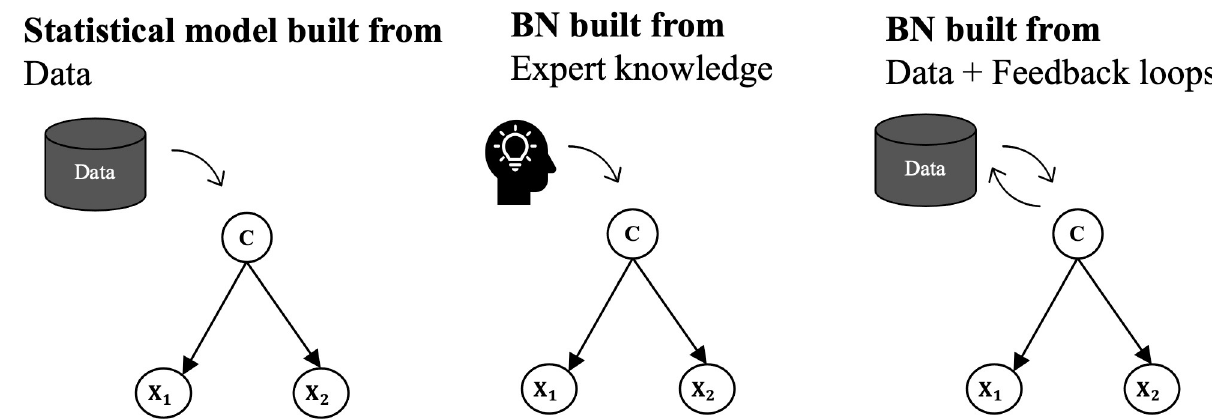
Fig 2. Different general approaches for building Bayesian